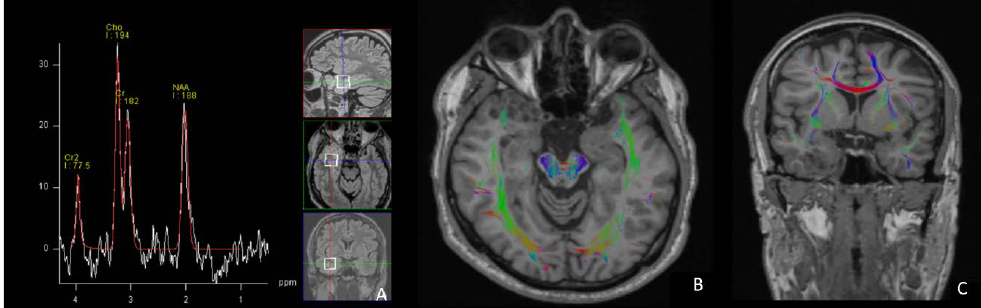
Figure 6. MR spectroscopy ( A ) shows a high choline peak and a lower N-acetyl aspartate peak. Tractography in axial ( B ) and coronal ( C ) planes shows disruption of the temporal stem fibers. Because we did not have enough data on the semiology of the seizure, we advised him to take anticonvulsant treatment according to the ILAE recommendation from 2017.